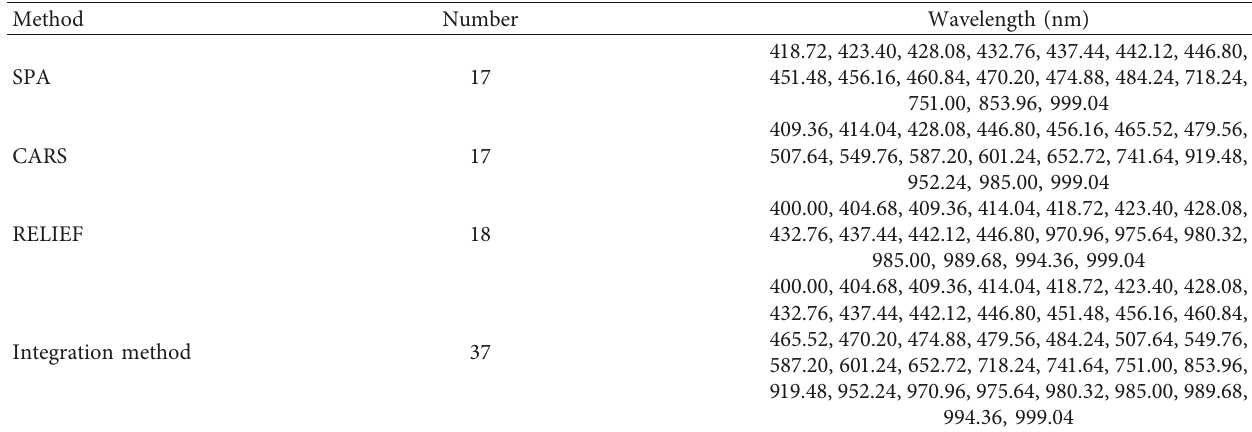
Figure 5: The wavelength selection process of the three methods. (a) SPA. (b) CARS. (c) RELIEF. Table 2: The results of the wavelength